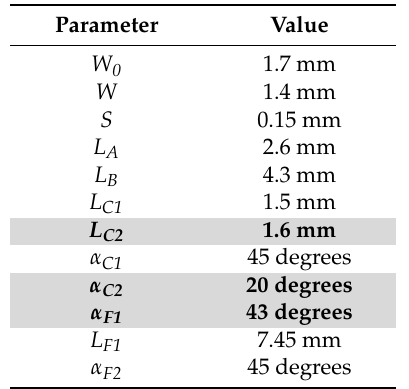
Table 1. Geometrical parameters of the optimized coupler (see Figure 2). The optimized parameters are reported in bold.